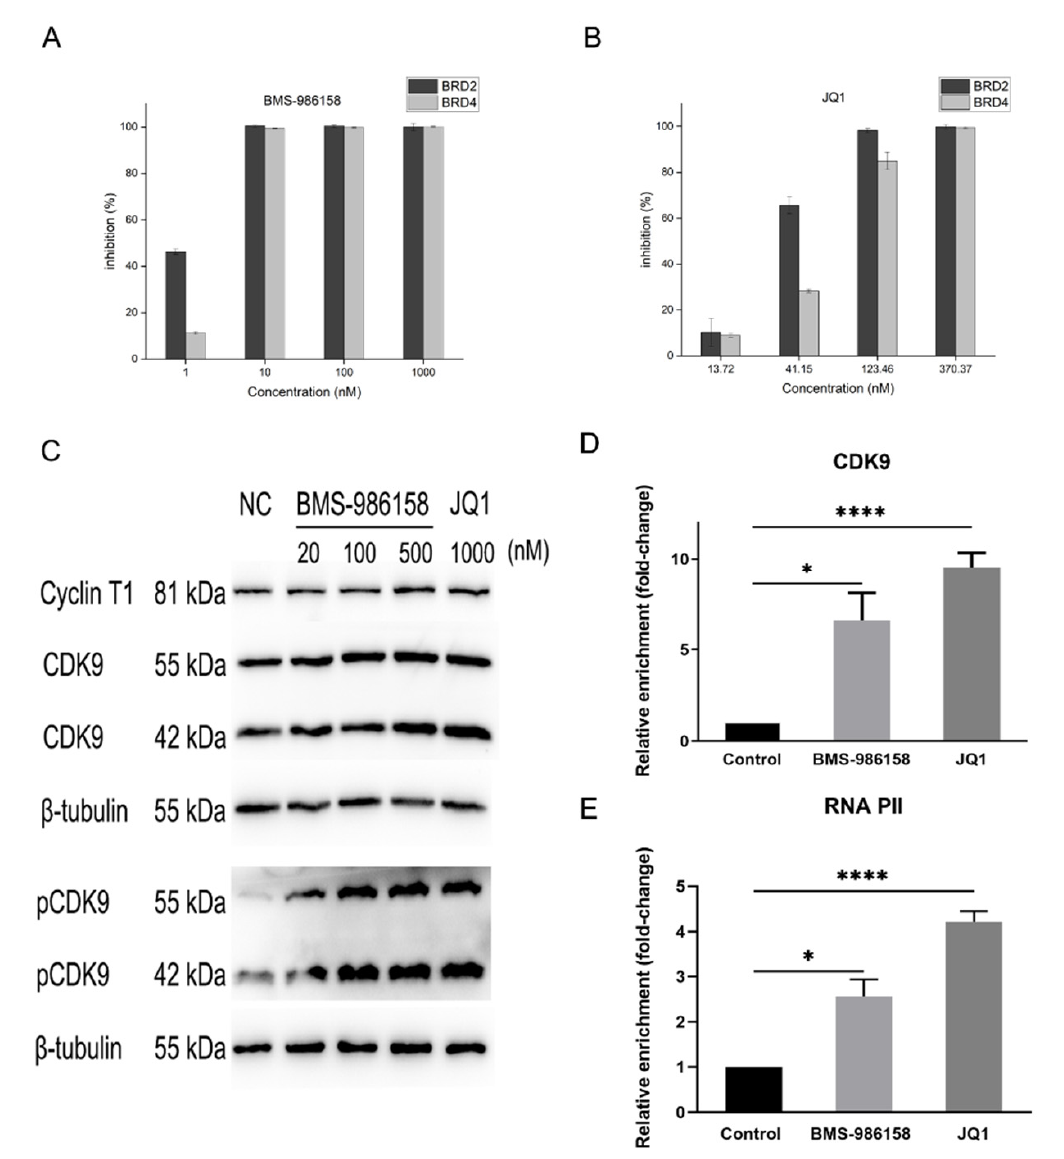
Figure 3. BMS-986158 reactivates latent HIV-1 by activating P-TEFb and promoting Figure 3. BMS ‐ 986158 reactivates latent HIV ‐ 1 by activating P ‐ TEFb and promoting recruitment of P ‐ TEFb and RNAP II. ( A , B ) BMS ‐ 986158 inhibited BRD2/4 activity in cell ‐ free reaction system. Dif ‐